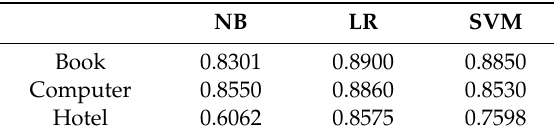
Table 4. Machine learning classification